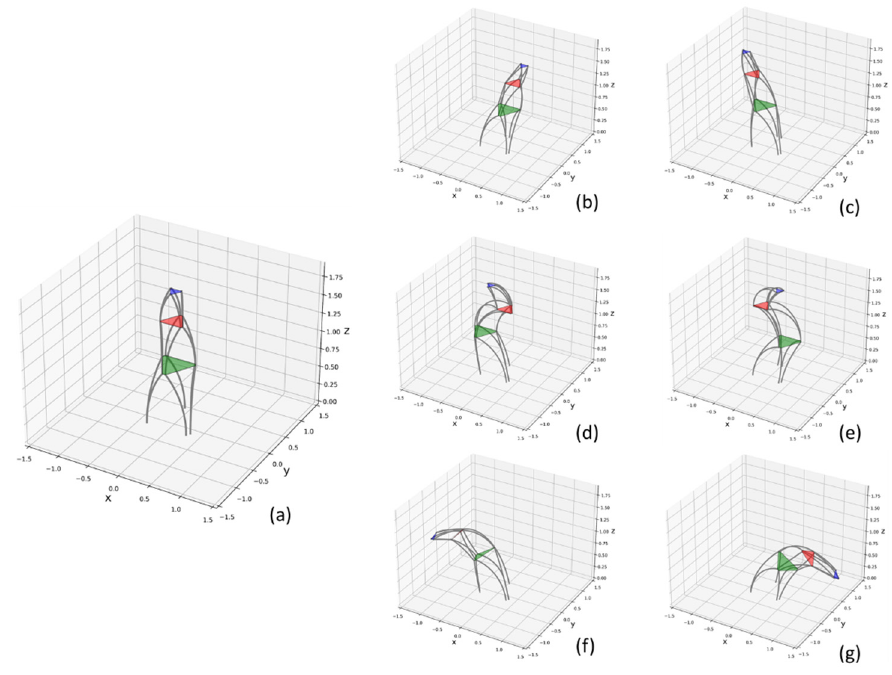
Figure 10. Simulation of flexible series-parallel mechanism. ( a ): initial orientation, ( b , c ): translation, ( d , e ): s-shaped orientation, ( f , g ): bending.